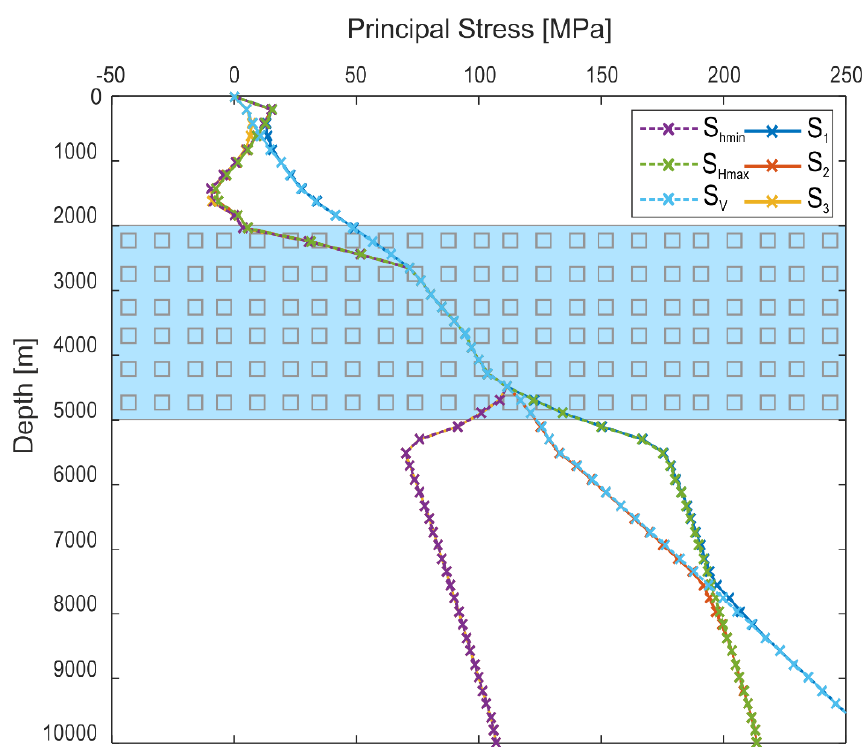
Figure 7 . Principal stress magnitudes for a hypothetical well (see W1 in Figure 2c) located in the centre of the model and of the salt diapir, respectively. Results are for Model B-04c, i.e., a salt diapir of 2000 m height, a salt viscosity of 10 18 Pa·s and 200 m of shortening in the subsalt section. The blue layer marks the depth interval covered by the salt diapir.